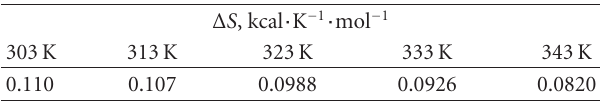
Table 9: The change in entropy ( Δ S ) for carbon steel in 1.0 M HCl in the presence of the aqueous extract of (2.0 g/L) Neem leaves at various temperatures (303K − 343